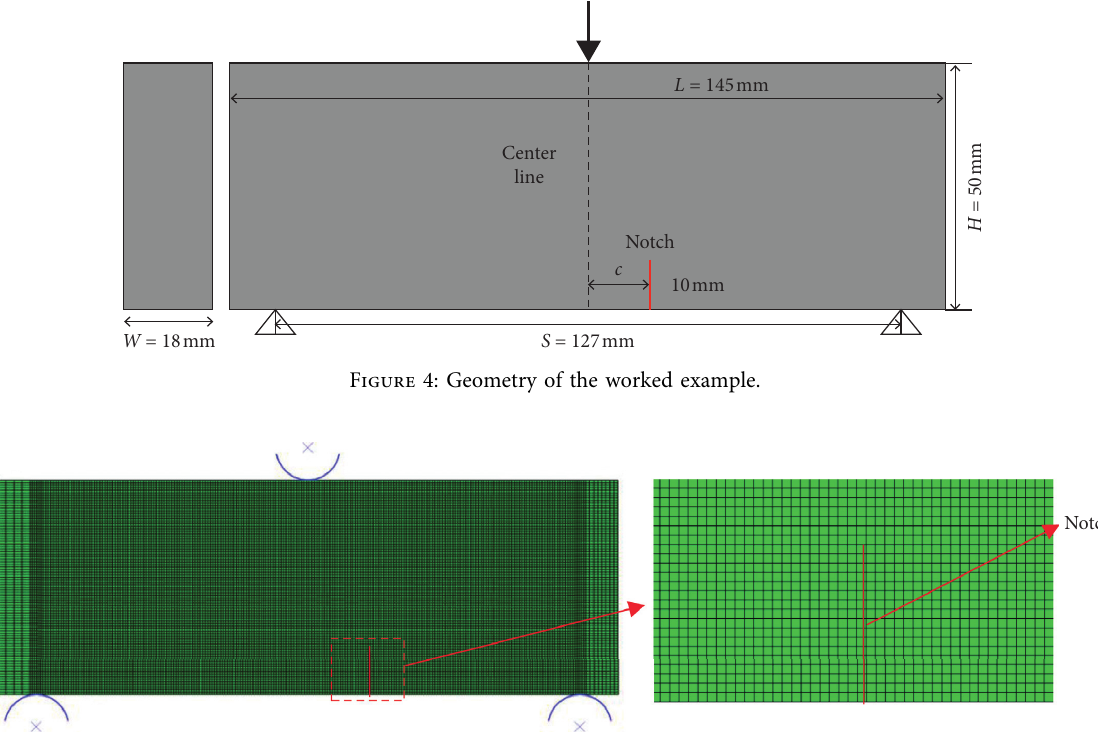
Figure 5: Numerical model for the beam with the notch of 20% offset ratio: (a) the whole model and (b) enlarged part around the notch.